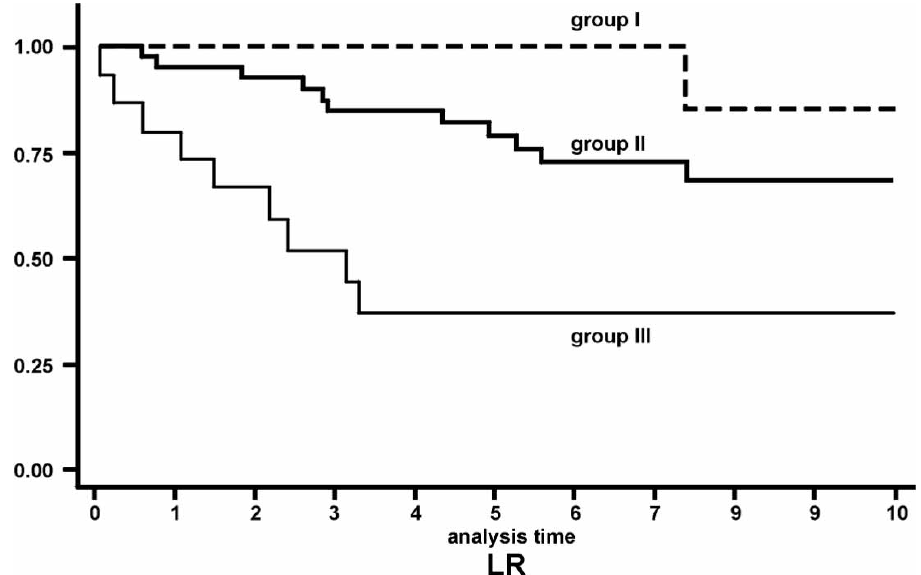
Fig. 1. Local recurrence-free survival curves of 81 patients with initial irradical excision for soft tissue sarcoma: group I, good prognosis ( n ¼ 23); group II, moderate prognosis ( n ¼ 43); group III, poor prognosis ( n ¼ 15).